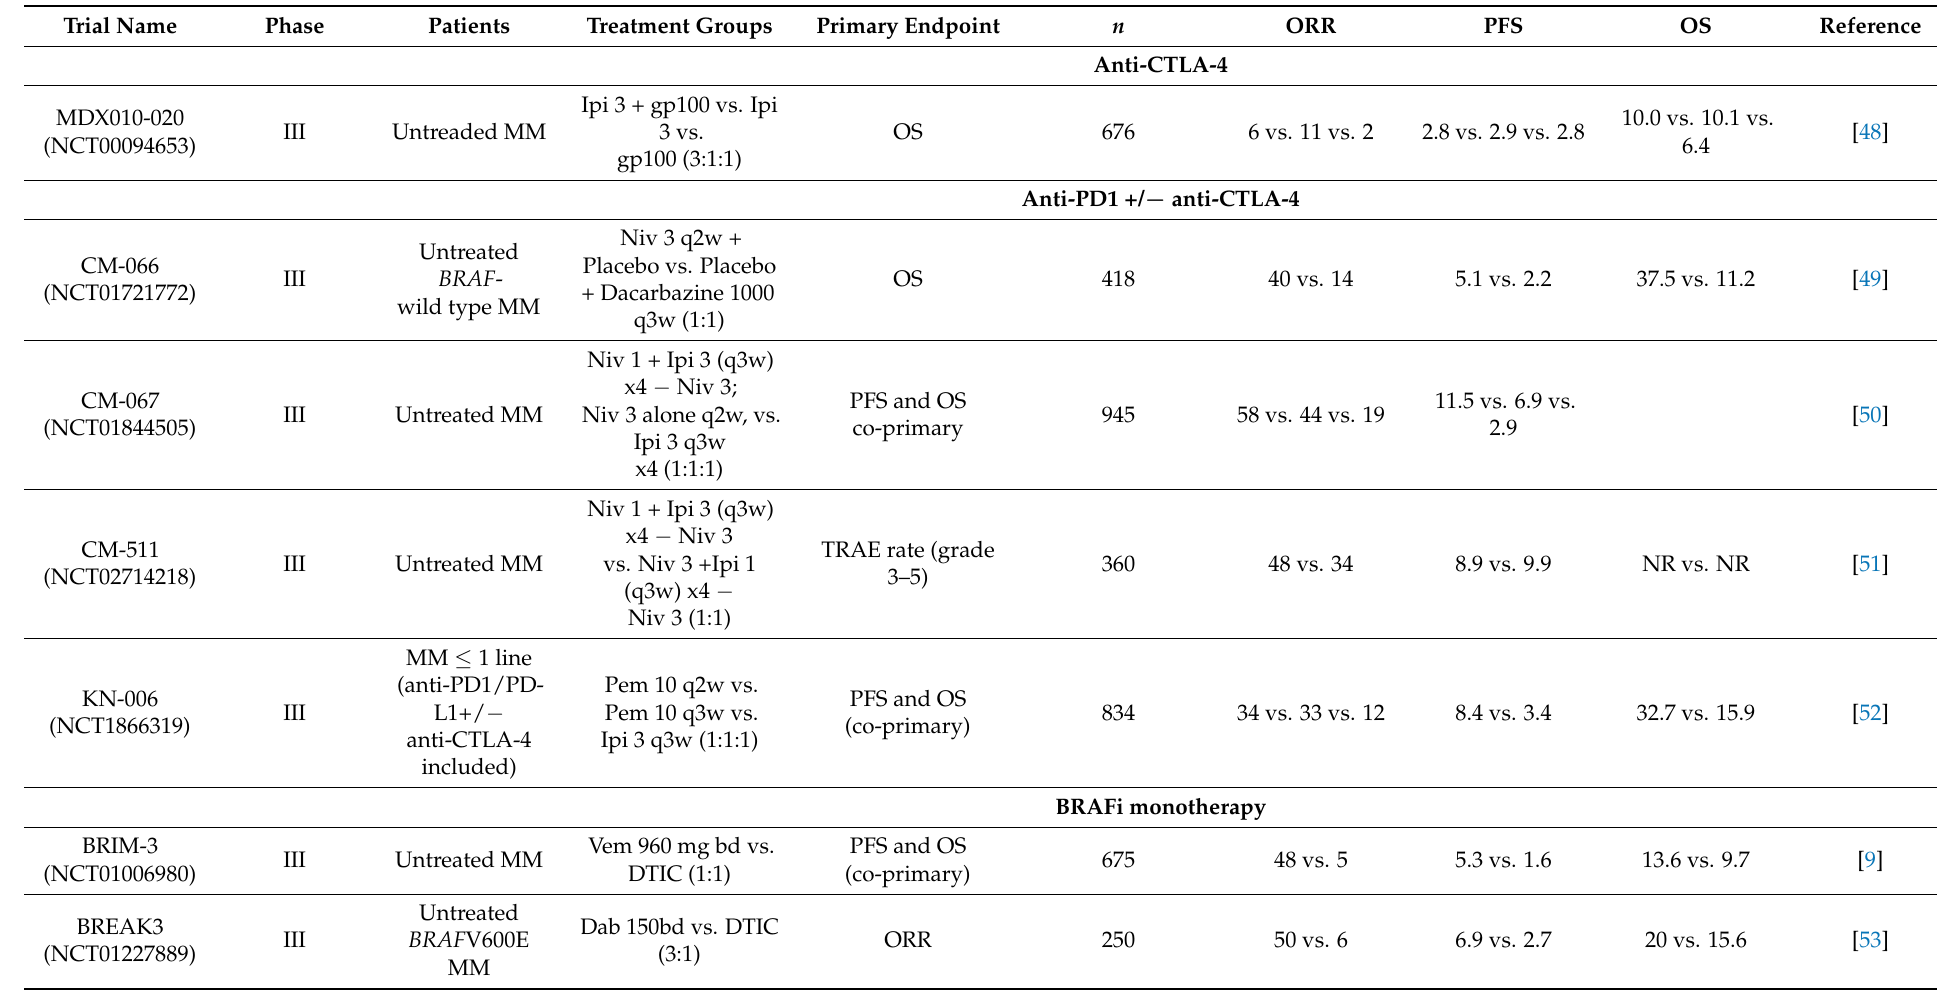
Table 2. Targeted therapy studies in melanoma patients with impact on clinical